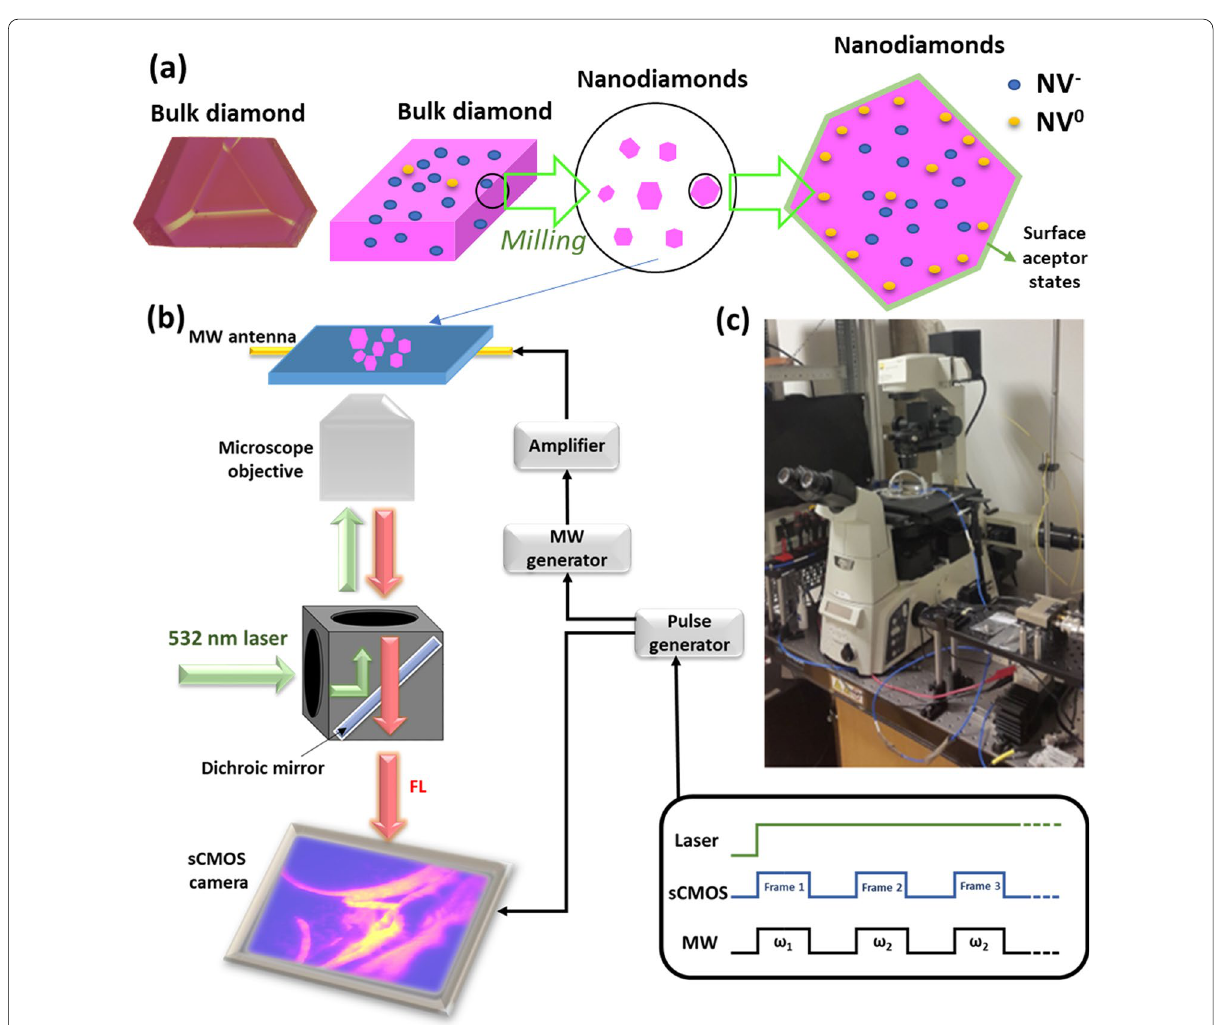
Fig. 1 Preparation of NDs and schematic of the wide‑field ODMR set‑up. a NDs, 156 nm and 48 nm in size were obtained by milling bulk, 13 C‑enriched HPHT fluorescent diamond. b Schematics of the inverted wide‑field ODMR microscope. Green laser light is focused onto the sample. The fluorescence is collected by the objective through a dichroic mirror to the high‑sensitivity CMOS camera. The image shows an actual fluorescence image of NDs deposited on a glass slide. MW delivery is obtained with a loop adjacent to the sample. The panel shows the temporal diagram of the CW‑ODMR experiment. The laser is kept ON during the entire measurement, while the camera detects the fluorescence image synchronously with the MW irradiation. c Photo of the wide‑field ODMR microscope